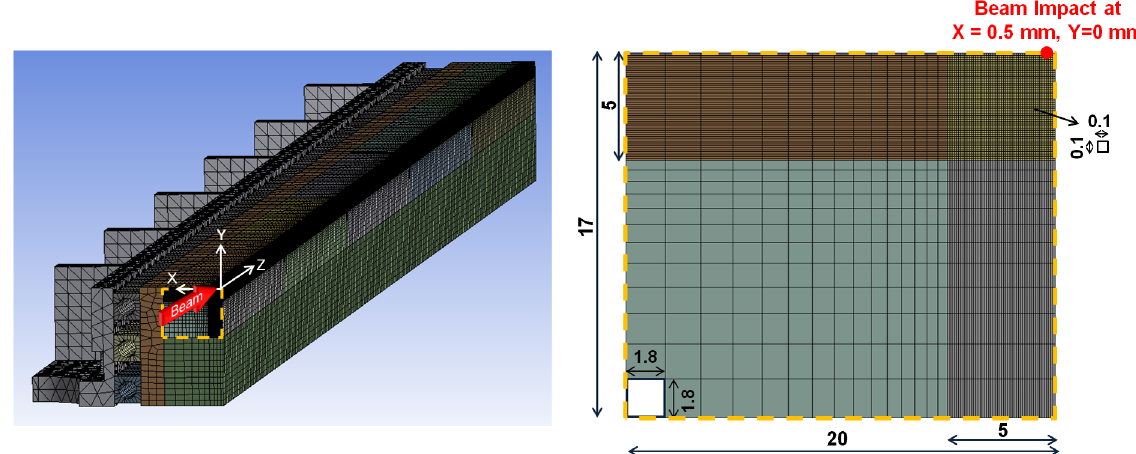
FIG. 10. Finite element discretization of the collimator jaw assembly for the thermal analysis. The discretized collimator model (left), and a detailed cross-sectional ( x - y ) view of the collimator jaw inserts (right). All dimensions are in mm. The total number of elements used for the thermal analysis model is 1,056,265.